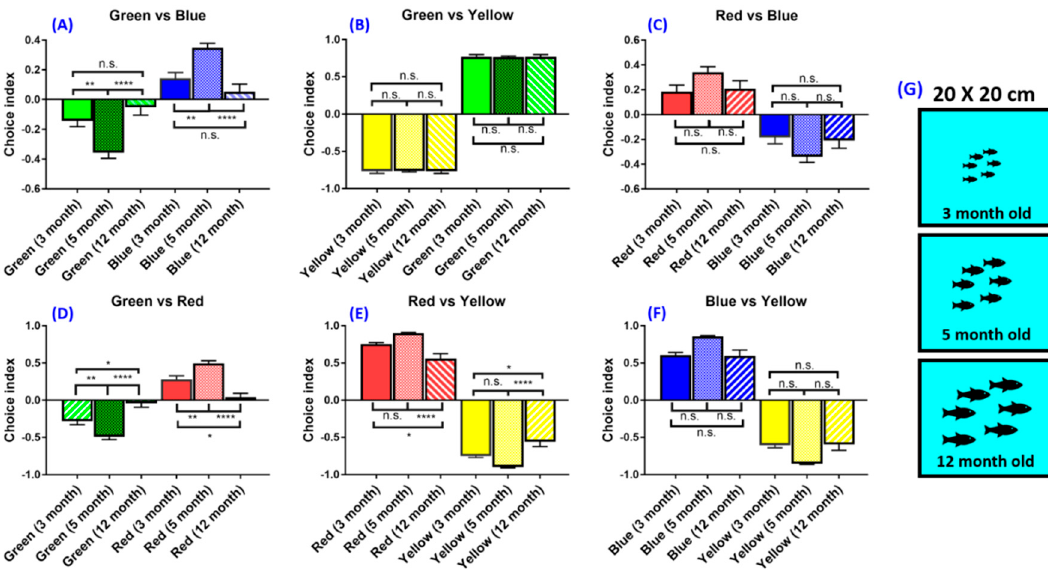
Figure 5. The effect of different ages on zebrafish color preference using the light source on top. ( A ) Green vs. blue combination, ( B ) green vs. yellow combination, ( C ) red vs. blue combination, ( D ) green vs. red combination, ( E ) red vs. yellow combination, ( F ) blue vs. yellow combination. ( G ) Schematics showing three settings with zebrafishes aged at either 3, 5 or 12 months old. The experiment was conducted with six zebrafishes inside one tank. The data are presented as mean ± SEM, n = 24 for each group. The difference was tested by one-way ANOVA and the significance level was set at * p < 0.05, ** p < 0.01, **** p < 0.0001. n.s. = non-significant.